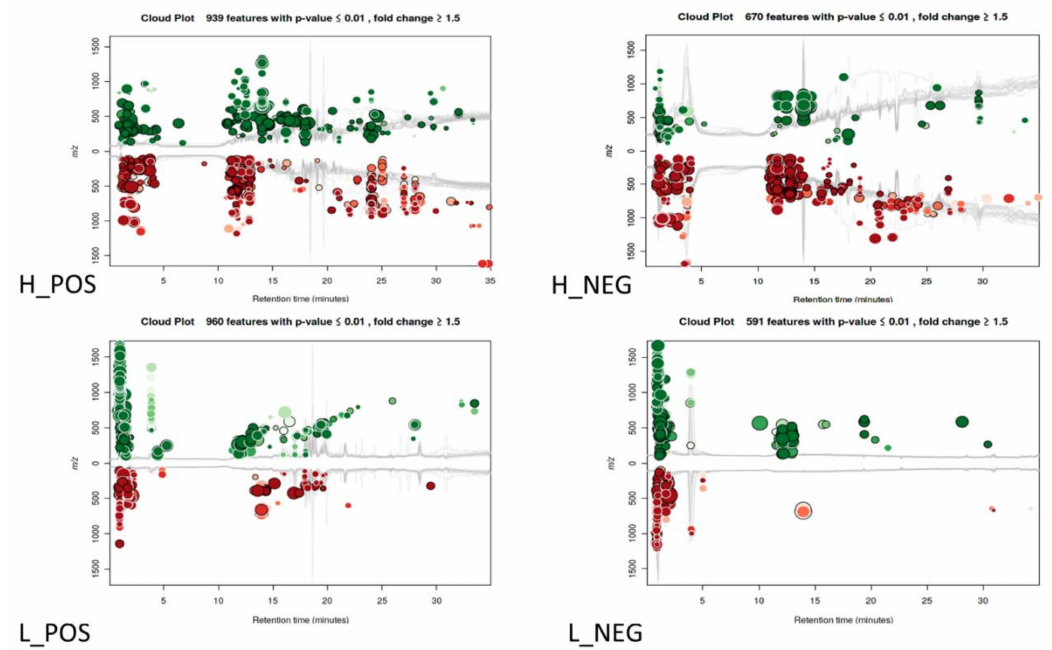
Figure 1. Cloud plot analysis of hydrophilic (H) and lipophilic (L) Mtb whole cell extracts analyzed in positive (POS) and negative (NEG) mode. Fold change > 1.5; p < 0.01. The color of the bubble denotes directionality of fold change and the size of the bubble denotes the extent of the fold change. Green color represents up-regulated metabolite features, while red color represents down-regulated metabolite